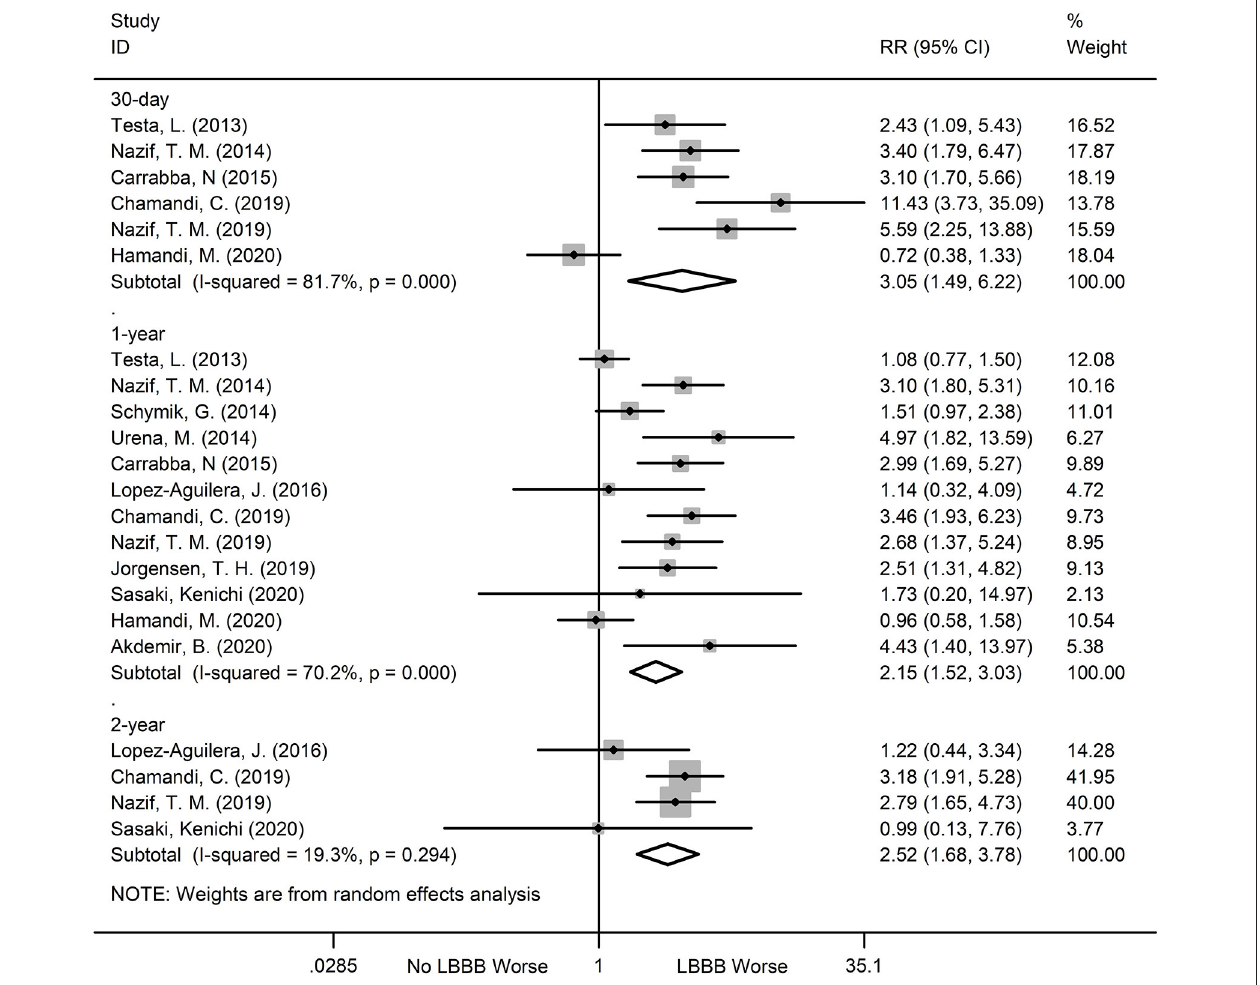
FIGURE 6 | Forest plot comparing PPI risk between patients with and without new-onset LBBB after